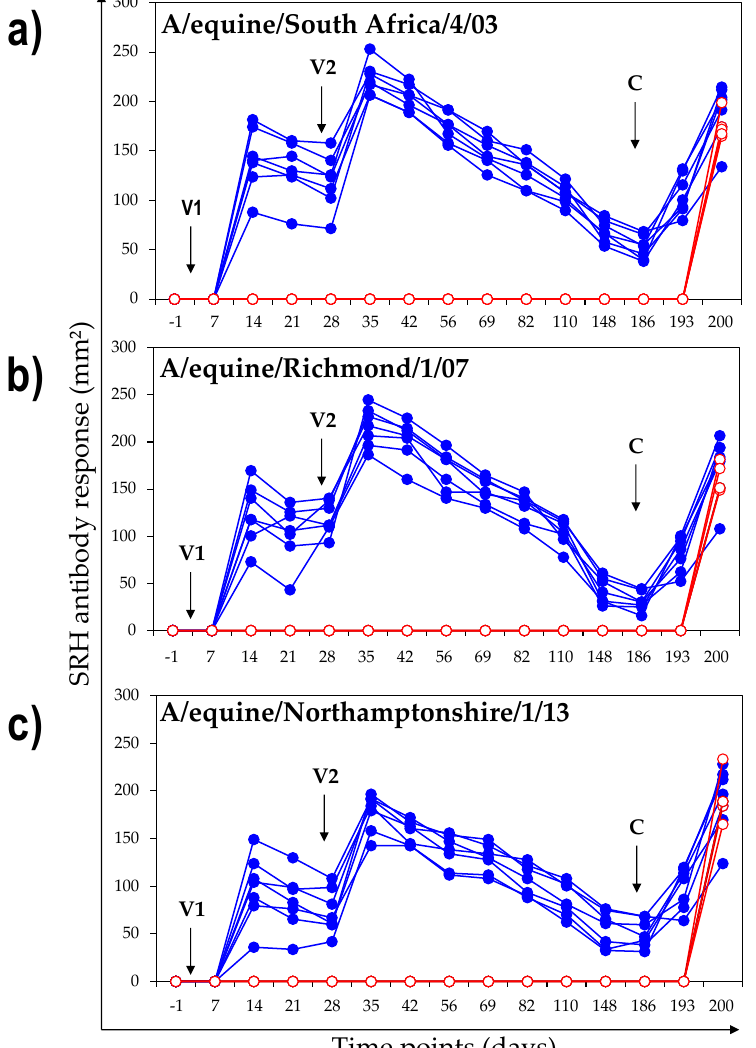
Figure 1. Individual single radial haemolysis (SRH) antibody response against A/equine/South Africa/4/03 ( a ) A/equine/Richmond/1/07 ( b ) and A/equine/Northamptonshire/1/13 ( c ). Vaccination and infection are indicated with arrows. Closed circles = vaccinated ponies; open circles = control ponies.